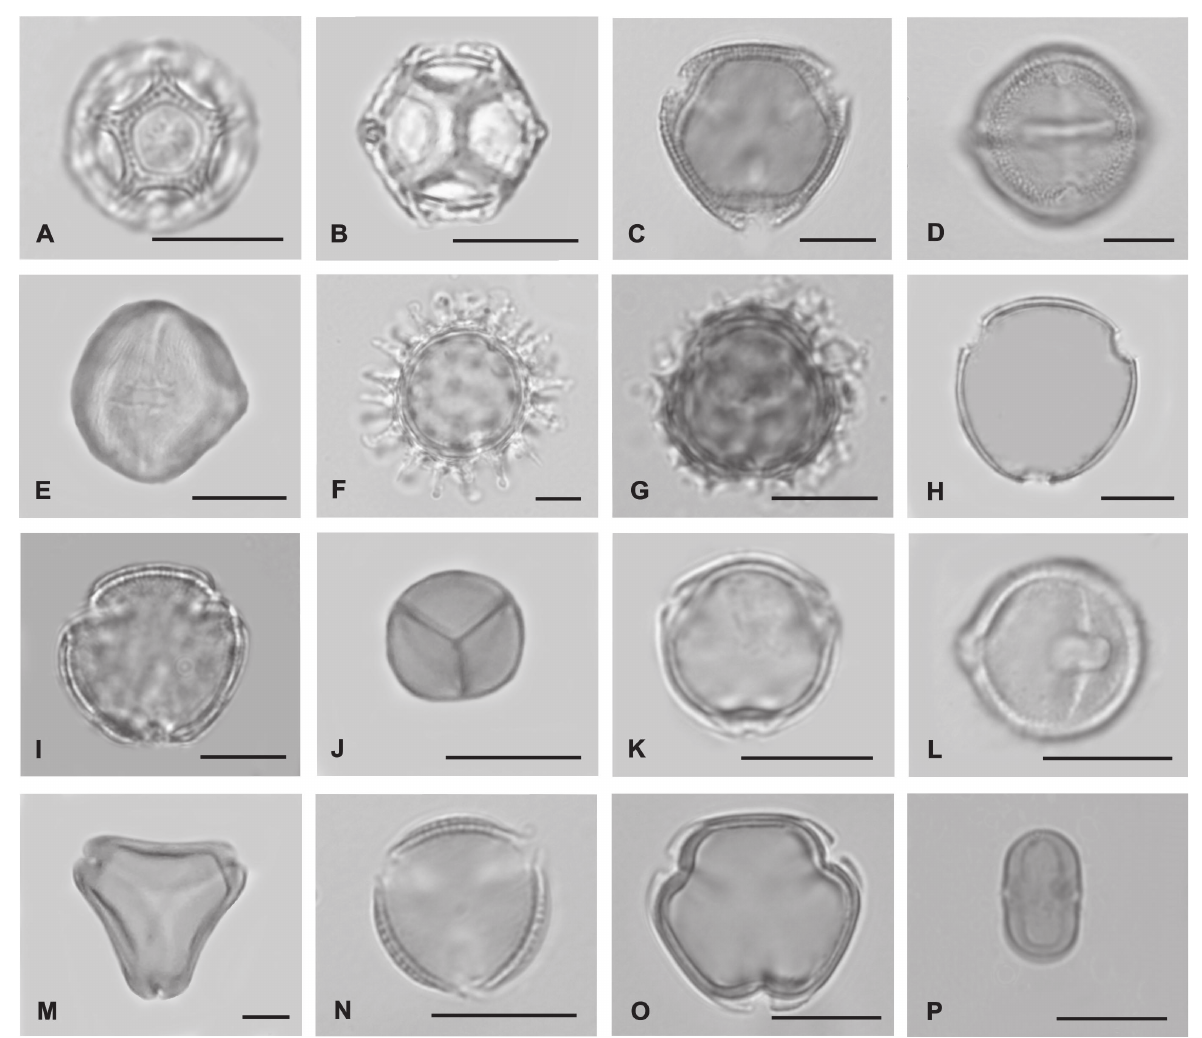
Fig 3 . Photomicrographs of pollen types recorded in pollen samples stored by Tetragonisca angustula (Latreille, 1811). Amaranthaceae : A-B. Alternanthera brasiliana – A. Aperture; B. Surface. Anacardiaceae : C-D. Anacardium ocidentale – C. Polar view; D. Equatorial view. E. Tapirira guianensis . Asteraceae : F. Aspilia . G. Baccharis retusa . Cannabaceae : H. Celtis . Fabaceae : I. Aeschynomene paniculata . J. Mimosa pudica . Malpighiaceae : K-L. Byrsonima – K. Polar view; L. Equatorial view. Myrtaceae : M. Eucalyptus . Plantaginaceae : N. Stemodia foliosa . Solanaceae : O. Solanum . Urticaceae : P. Cecropia . Scale bar 10